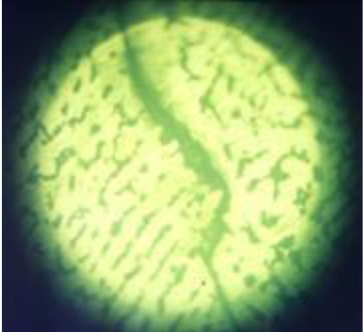
Figure 5. Intercrystalline crack.